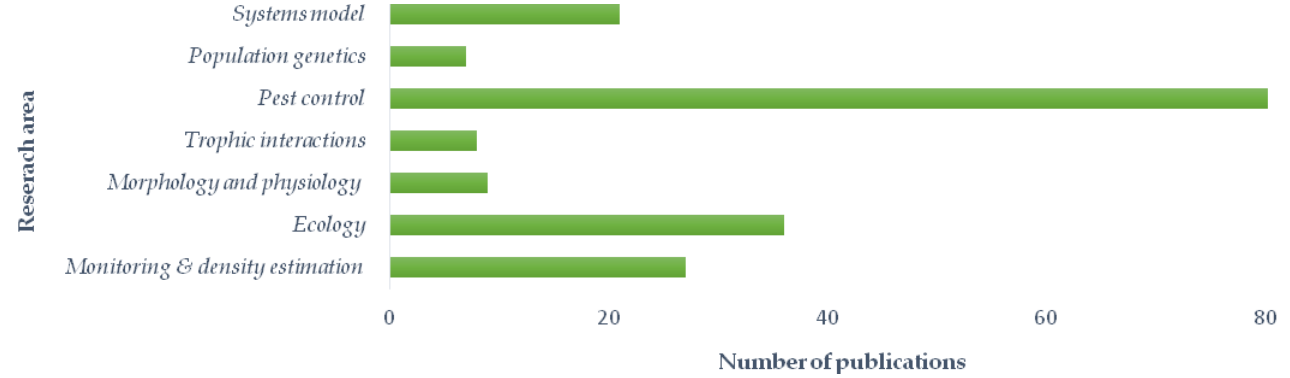
Figure 1. Western corn rootworm (WCR) research area in Europe and published papers accordingly.